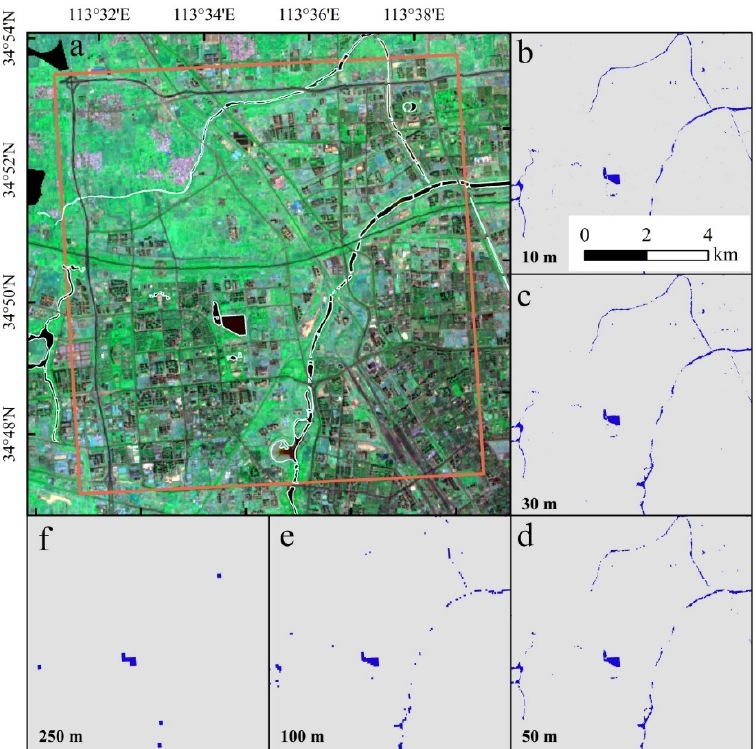
Figure 13. Scale effect in experimental area A: ( a ) white lines in remote ‐ sensing image indicate real surface water boundaries, ( b ) water area extracted using Sentinel ‐ 2A 10m ‐ resolution data, ( c ) water area extracted using Landsat ‐ 8 30m ‐ resolution data, ( d ) water area resampled to 50 m from Sentinel ‐ 2A 10m ‐ resolution data, ( e ) water area resampled to 100 m from Sentinel ‐ 2A 10m ‐ resolution data, and ( f ) water area extracted using MODIS 250 ‐ resolution data.